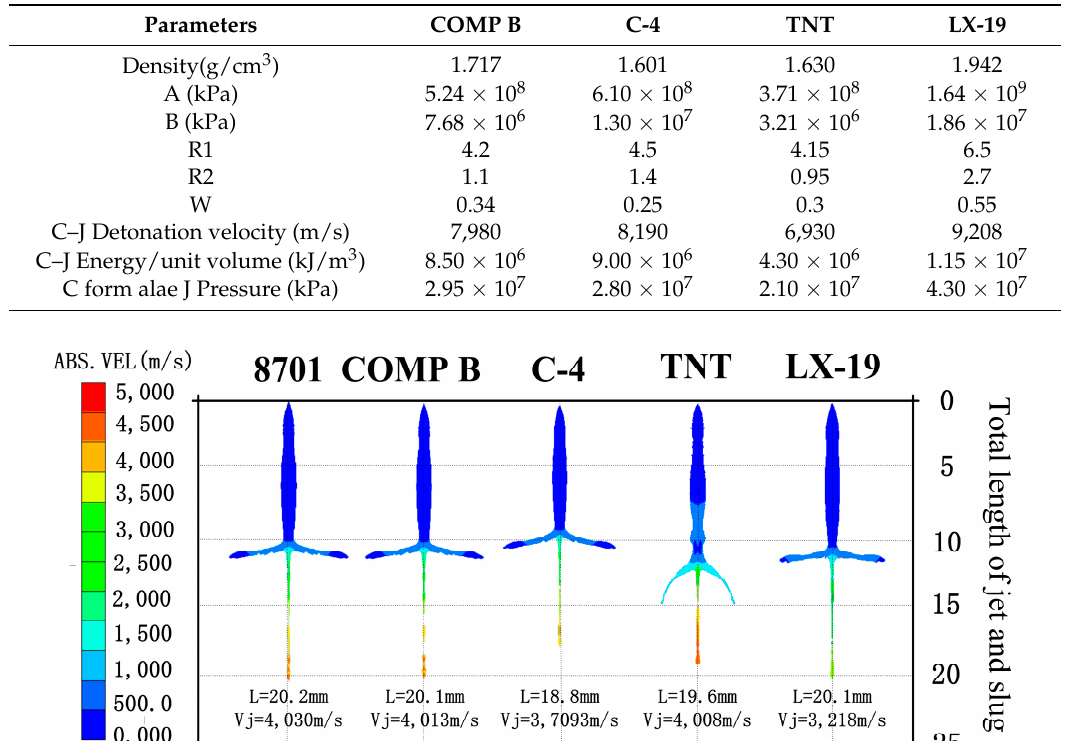
Figure 11. Penetration depth of BLSCs with different liner thickness.